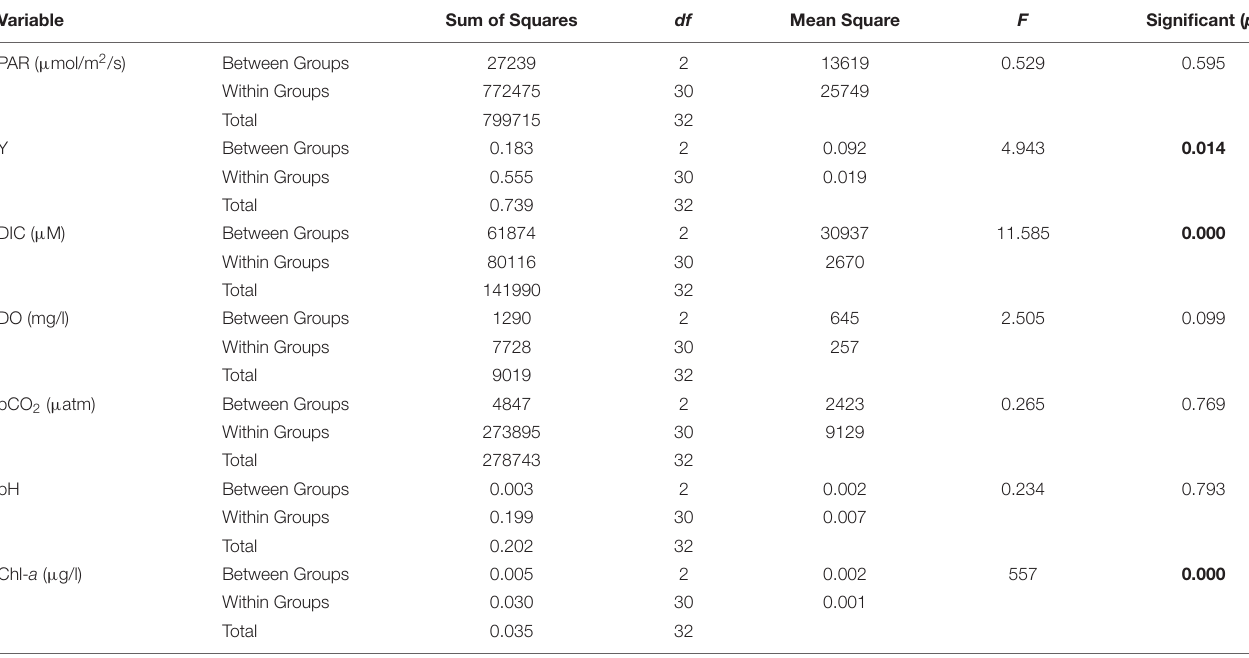
TABLE 3 | Results of One-Way Repeated Measures ANOVA between selected parameters [Photosynthetically Active Radiation (PAR), effective quantum yield (y), dissolved inorganic carbon (DIC), Dissolved oxygen (DO), partial pressure of CO 2 (pCO 2 ), pH and Chl- a ] recorded from (1) Cymodocea serrulata , (2) Thalassia hemprichii, (3) Enhalus acoroides (values in bold indicate statistically significant results).